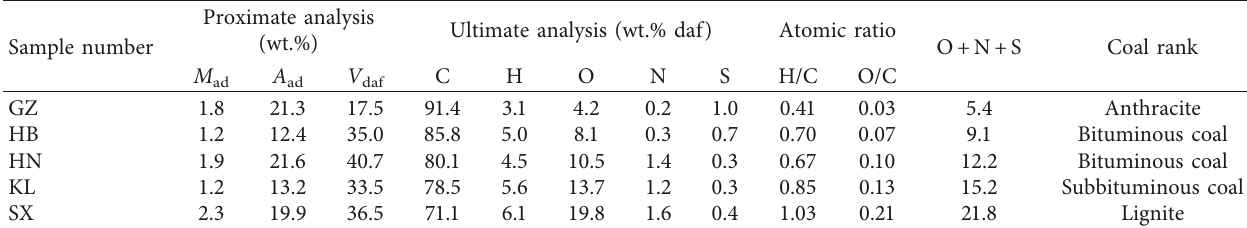
Figure 1: Location and geological ages of Huainan coalfield, Kailuan coalfield, and Pingshuo coalfield in the North China coal-bearing region and Enshi coalfield and Zhijin coalfield in the South China coal-bearing region. Table 1: Results of proximate and ultimate analyses for five coal